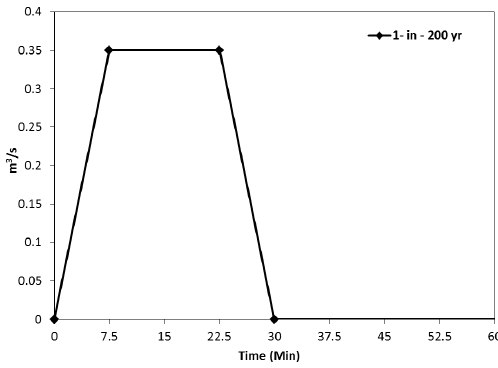
Fig. 2. Inflow boundary